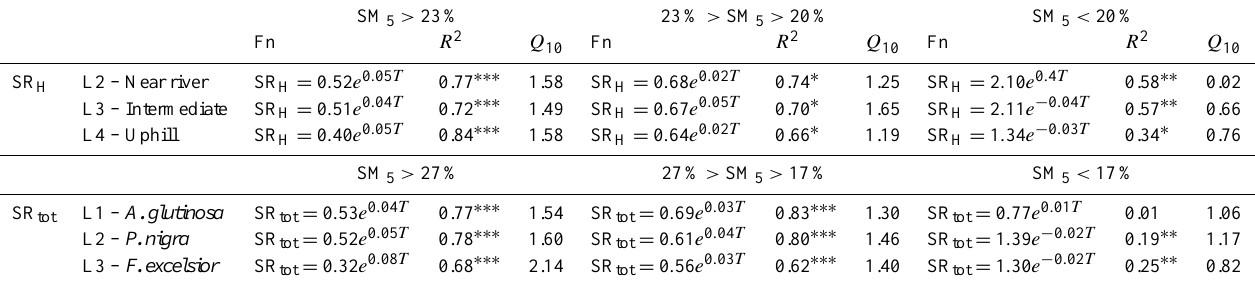
Table 4. Exponential relationships between soil respiration (SR) and soil temperature ( T ), and Q 10 for different SM 5 intervals. Heterotrophic SR (SR H ). Total SR (SR tot ). (SM 5 ) is 5cm integral soil moisture.